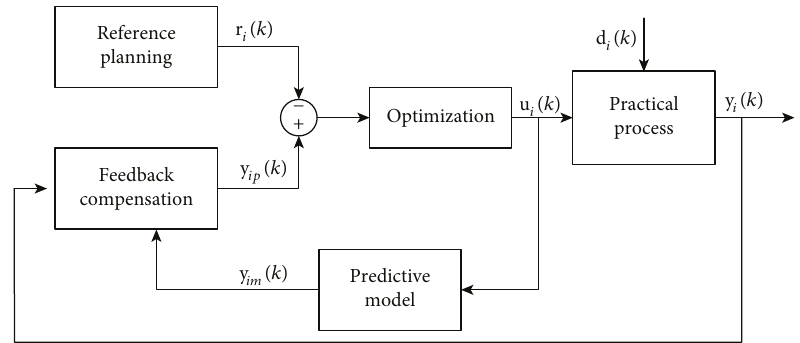
Figure 3: Flowchart of typical